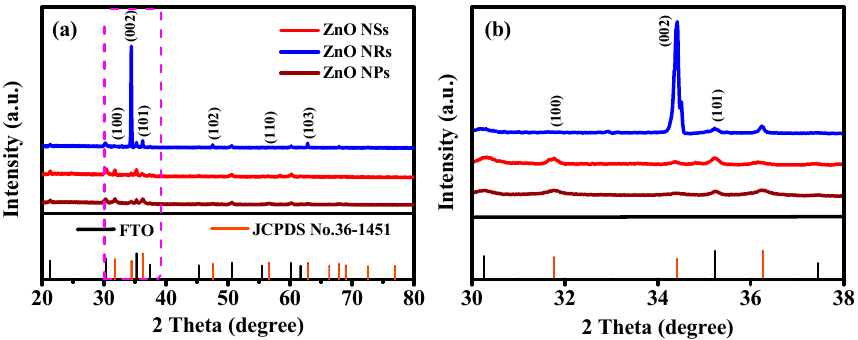
Figure 2. The morphologies of three ZnO nanostructures. SEM image of ( a ) ZnO NSs, ( b , c ) ZnO NRs, and ( d ) ZnO NPs. Cross-sectional SEM image of ( e ) ZnO NSs, ( f ) ZnO NRs, and ( g ) ZnO NPs. Moreover, the crystalline structures of the three samples were confirmed by XRD analysis. Figure 3a shows the XRD spectrums of the various ZnO nanostructures that were grown on the FTO substrate, and Figure 3b presents vertically enlarged XRD patterns of the inside of the pink dashed line in Figure 3a. The ZnO NRs peaks are detected at 34.43°, 36.25°, 47.52°, and 62.86°, and they represent lattice planes (002), (101), (102), and (103), respectively. The ZnO NSs peaks are detected at 31.70°, 34.42°, 36.25° and 56.46°, and they represent lattice plane (100), (002), (101) and (110), respectively. Similarly, The ZnO NPs peaks are detected at 31.70°, 34.42°, 36.25°, and 56.46°, and they represent lattice plane (100), (002), (101), and (110), respectively. The detected peaks of three ZnO nanostructures match the standard ZnO diffraction pattern (JCPDS, No. 36-1451), indicating that three morphologies of ZnO have the same crystalline structure, which is a wurtzite structure. Notably, the peak at 34.43° is the highest in the ZnO NRs, indicating that the ZnO NRs are mainly grown on a lattice plane (002). The results of the XRD of three ZnO nanostructures match well with the results of their SEM images.